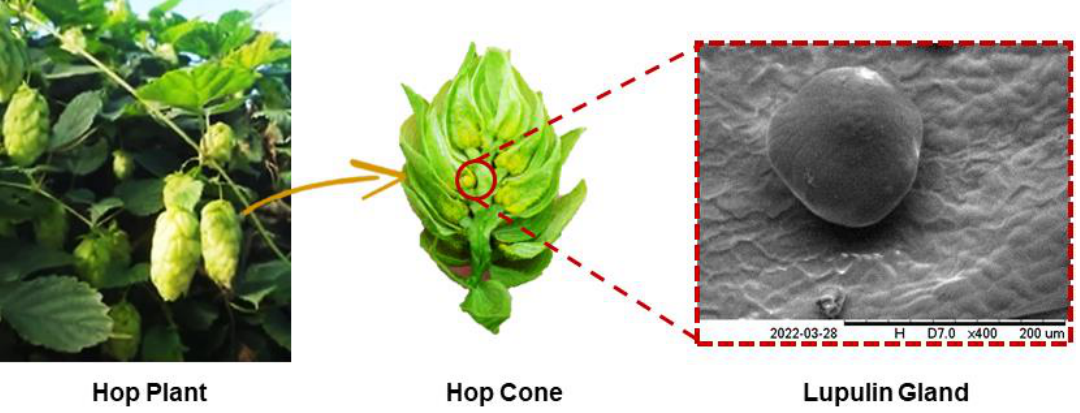
Figure 3. Hops flowers in situ, a transversal cut of hops cone, and lupulin glands via an image from an scanning electronic microscopic (data provided by authors).